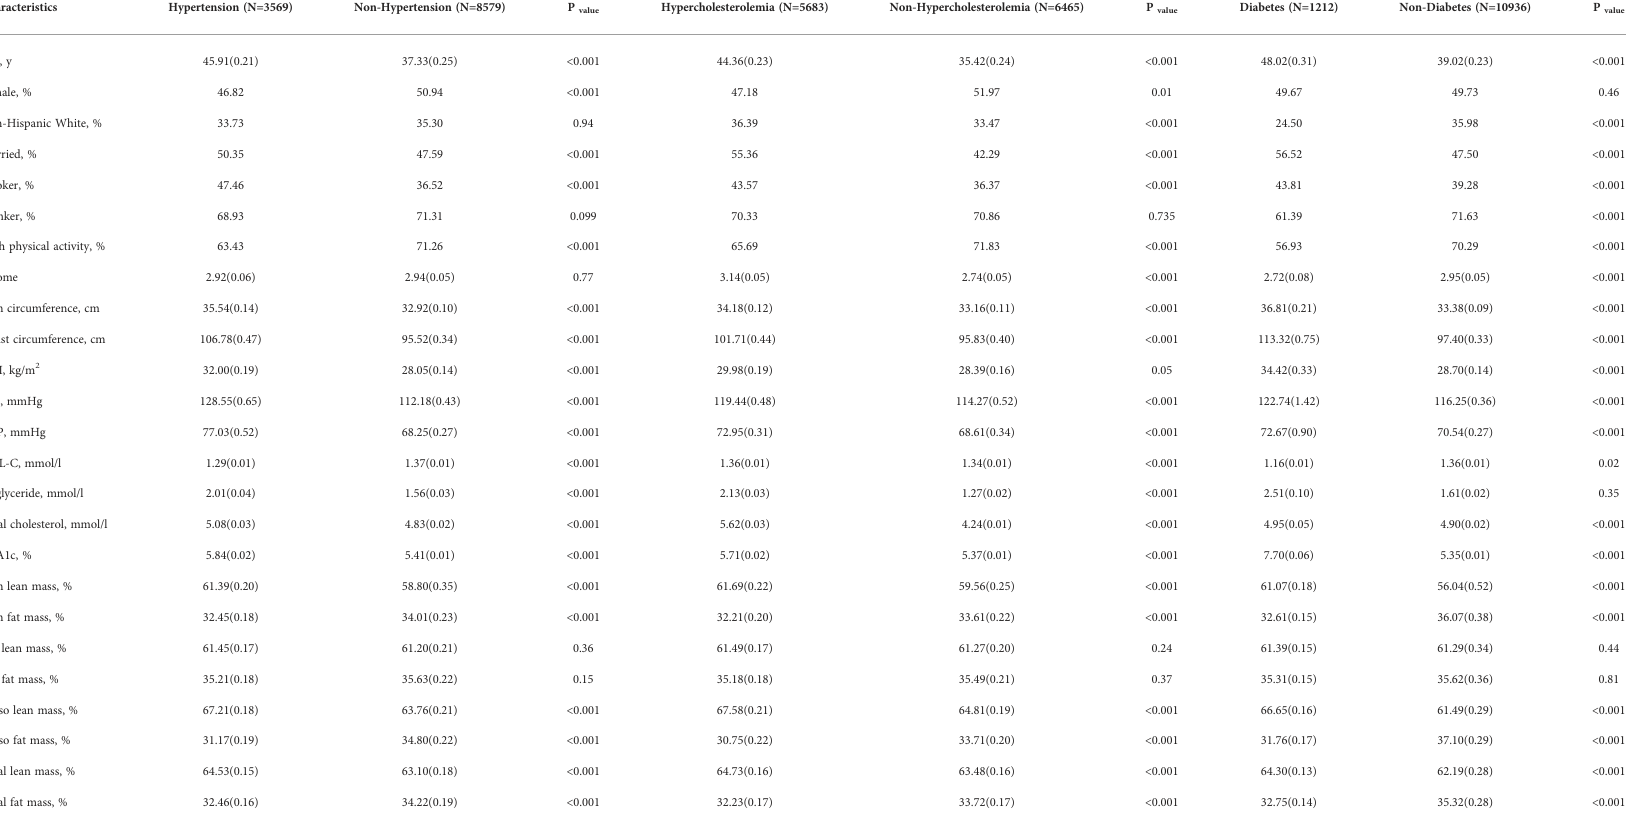
TABLE 1 Baseline characteristics in case and control groups: NHANES